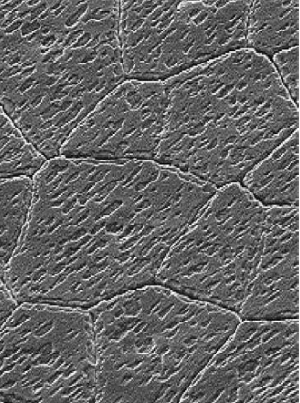
Figure 1. SEM image showing that the imprints of nano-asperity grooves correspond to the crystal directions of the aragonite platelets. Reproduced from [2] with permission from The Royal